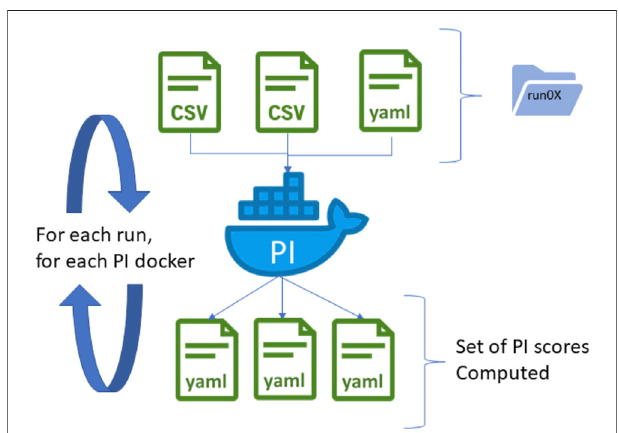
FIGURE4| PIcomputationbasedondockerizedalgorithms.Algorithms are deployed into Docker images, providing a generic interface to the algorithm independent of the programming language. The Docker container expects preprocessed data fi les of a single run as input and generates a set of PI scores in YAML fi les. If several runs or conditions are available, the Docker image is relaunched successively for each iteration, providing scores for each